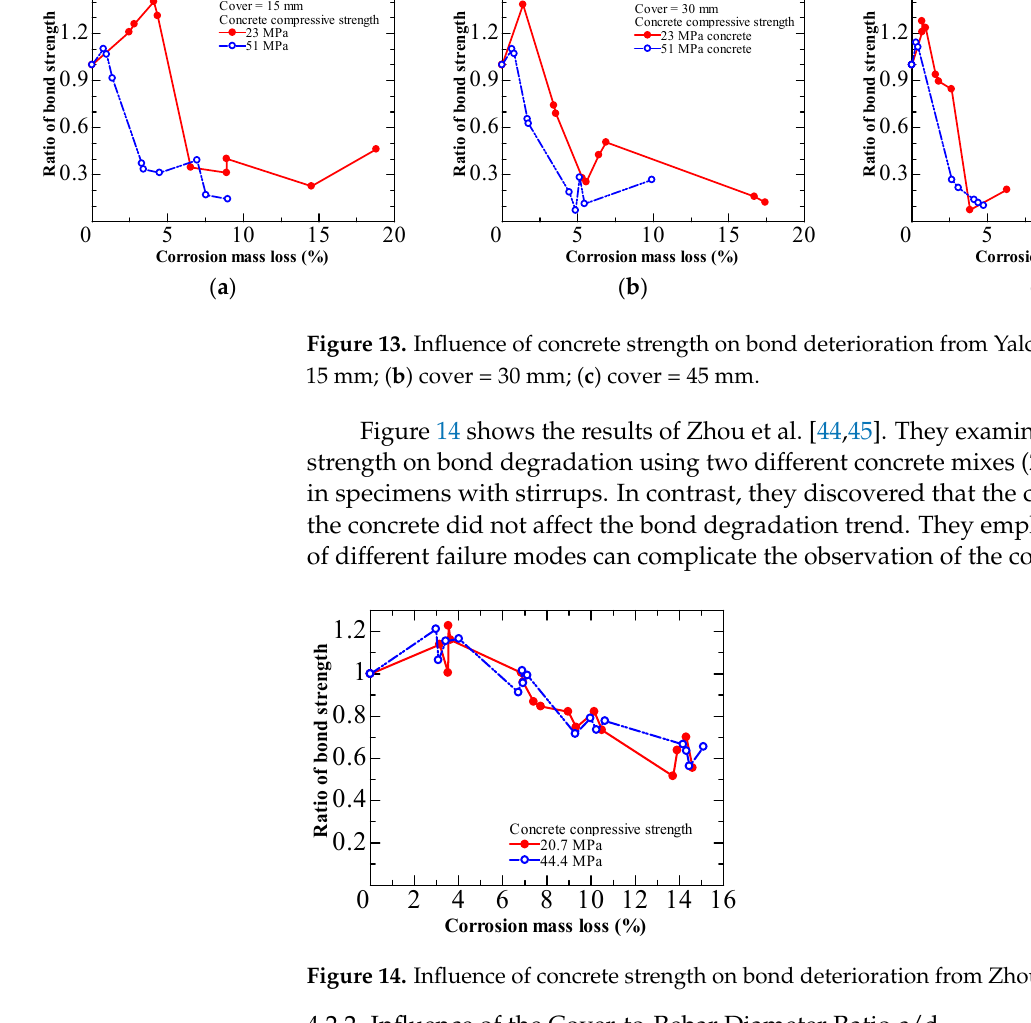
Figure 14. Influence of concrete strength on bond deterioration from Zhou et al. [42].